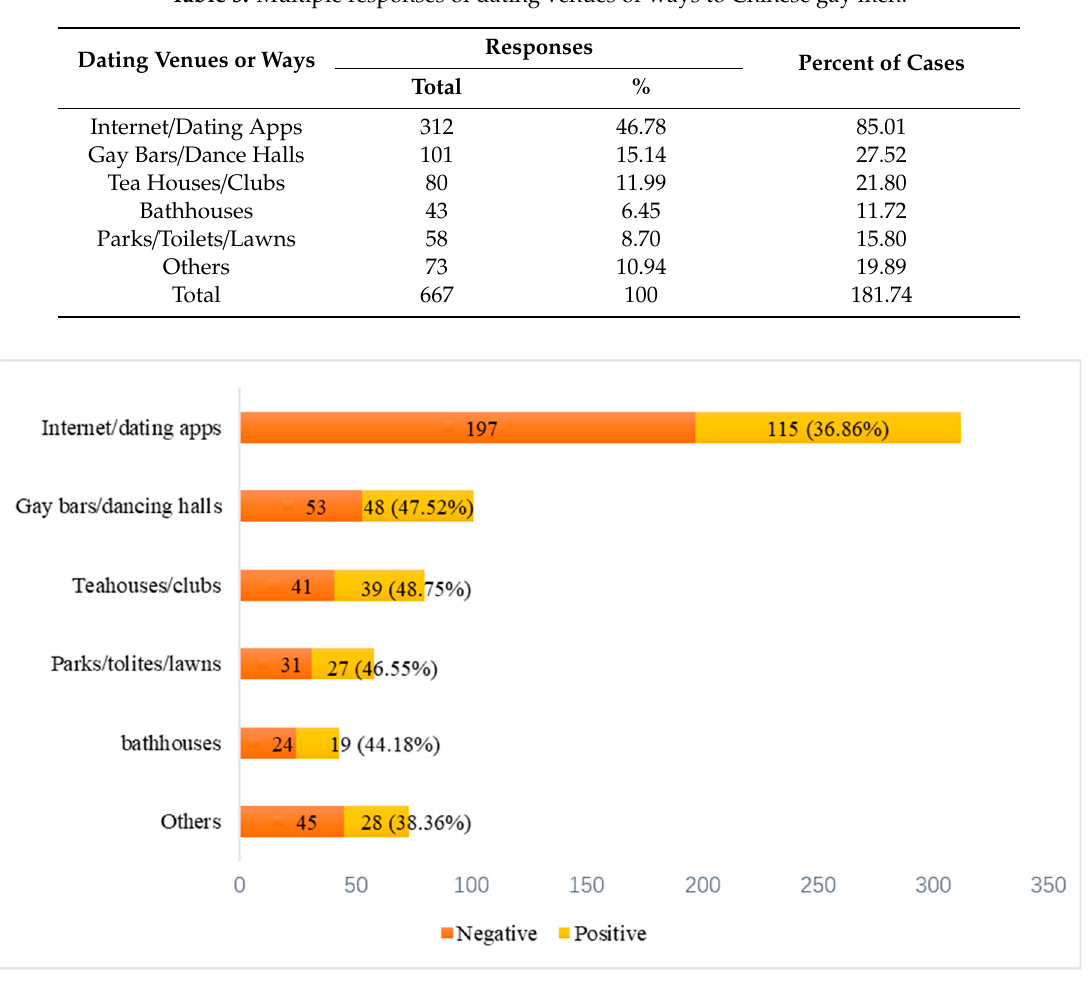
Figure 1. Dating venues and IS detection among Chinese gay men.